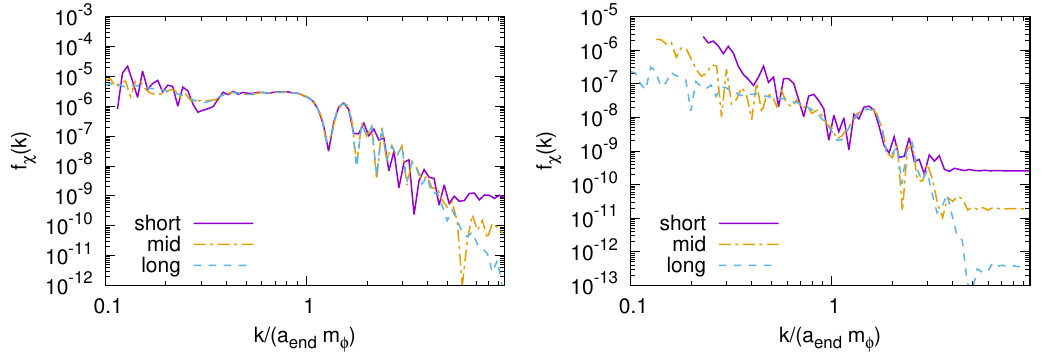
Figure 2 . The phase space density of (cid:31) after the gravitational particle production for the minimal coupling (cid:24) = 0. The three lines \short", \mid" and \long" correspond to the duration of in(cid:13)ation in a numerical calculation. We have taken m (cid:31) = m (cid:30) (left) and m (cid:31) = 2 m (cid:30)